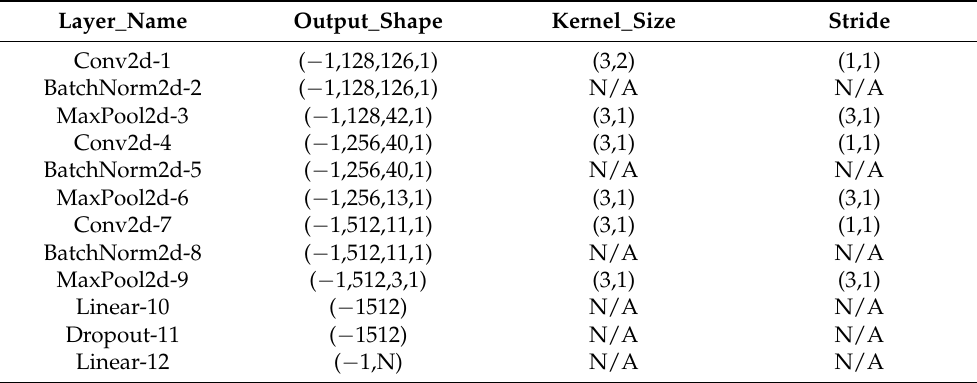
Table 1. The neural network structure (RML2016.04c).